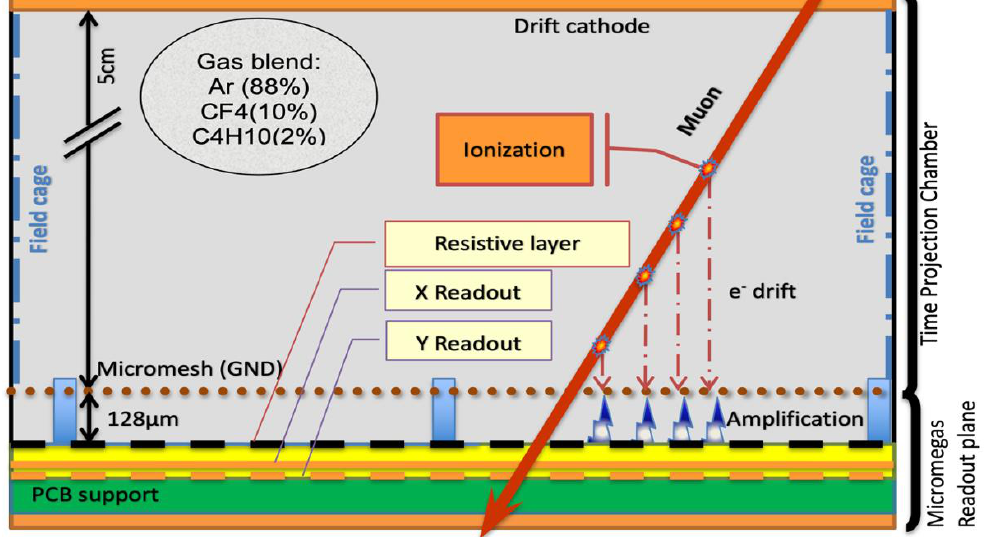
Figure 1. Schematic cross-section of the MUST 2 detector to illustrate its working principle. Figure from [16].